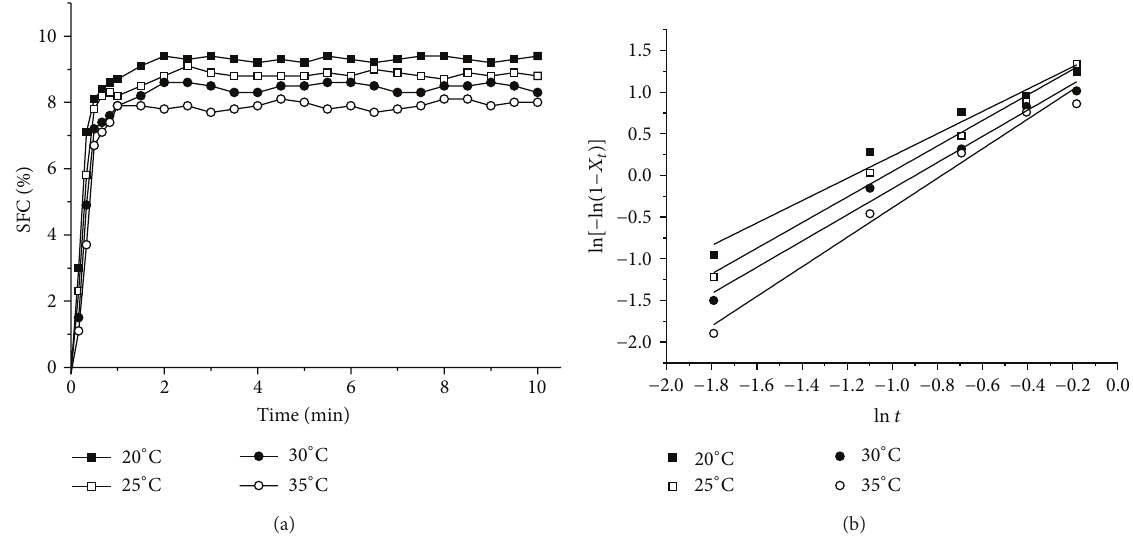
Figure 1: (a) SFC versus time of crystallization for MAG organogels at 20, 25, 30, and 35 ∘ C. (b) Plots of ln [− ln (1 − 𝑋 𝑡 )] versus ln 𝑡 for isothermal crystallization of MAG organogels at 20, 25, 30, and 35 ∘ C, respectively.